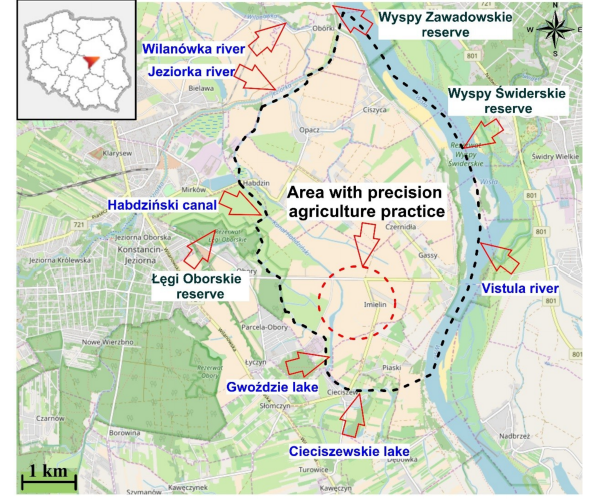
Figure 1. Location of the study area, and the surroundings; black dashed line indicates the borderline of the modeled